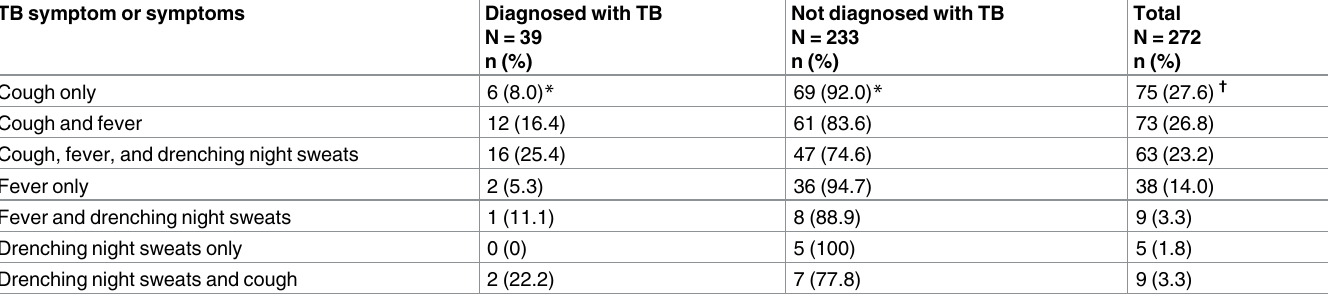
staff to read the TST result and 52 (16.4%) had a positive TST ( (cid:21) 5 mm of induration). None of the 28 participants in Chiang Mai or the 39 participants in Phitsanulok had a positive TST; while 15 (42.9%) of 35 in Nakhon Si Thammarat, 10 (25.0%) of 40 in Tak, 11 (20.4%) of 54 in Phuket, and 16 (13.2%) of 121 participants in Chiang Rai, and had positive TST results. Partici- pants with positive TST results did not differ significantly from those with negative TST results by age, sex, weight, or CD4 count (Table 4). Table 3. Assessment of 272 people living with HIV who reported tuberculosis symptoms at baseline. TB symptom or